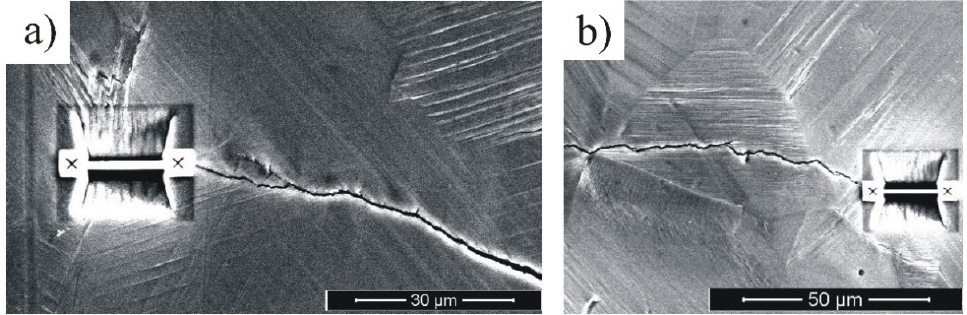
Figure 2. TEM samples of ( a ) X2-12 ref and ( b ) X2-12 H2, prepared with